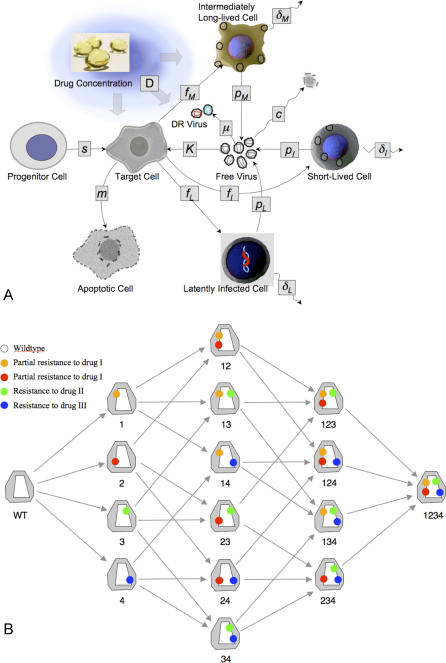
Overview of Cell Populations (A) and Mutations Responsible for Resistance (B)Mutation accumulation was modeled as a sequential process in which each genotype can acquire a single additional mutation in any given time-step (0.002 d in our simulations). In a single time step, V
1, for example, could mutate to V
12, V
13, or V
14, but not to V
123. The model also allows for recombinational steps (see text), which are not depicted here.